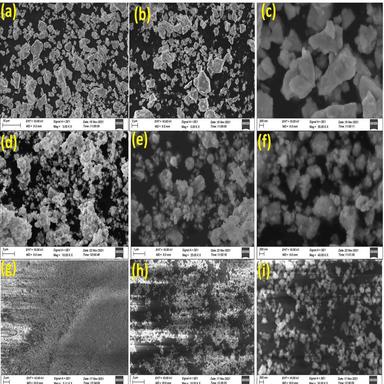
(a–i) SEM images at different magnifications, (a-c) Pure Sb, (d-f) Sb-Ball-milling (g-i) Sb-NMP samples.